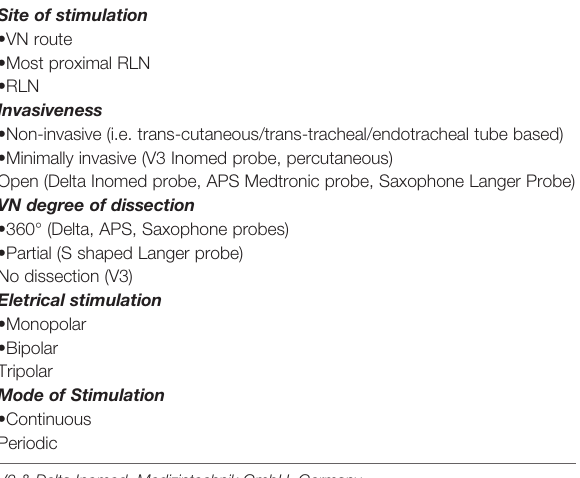
TABLE 2 | Classi fi cation of C-IONM modalities. Site of stimulation (cid:129) VN